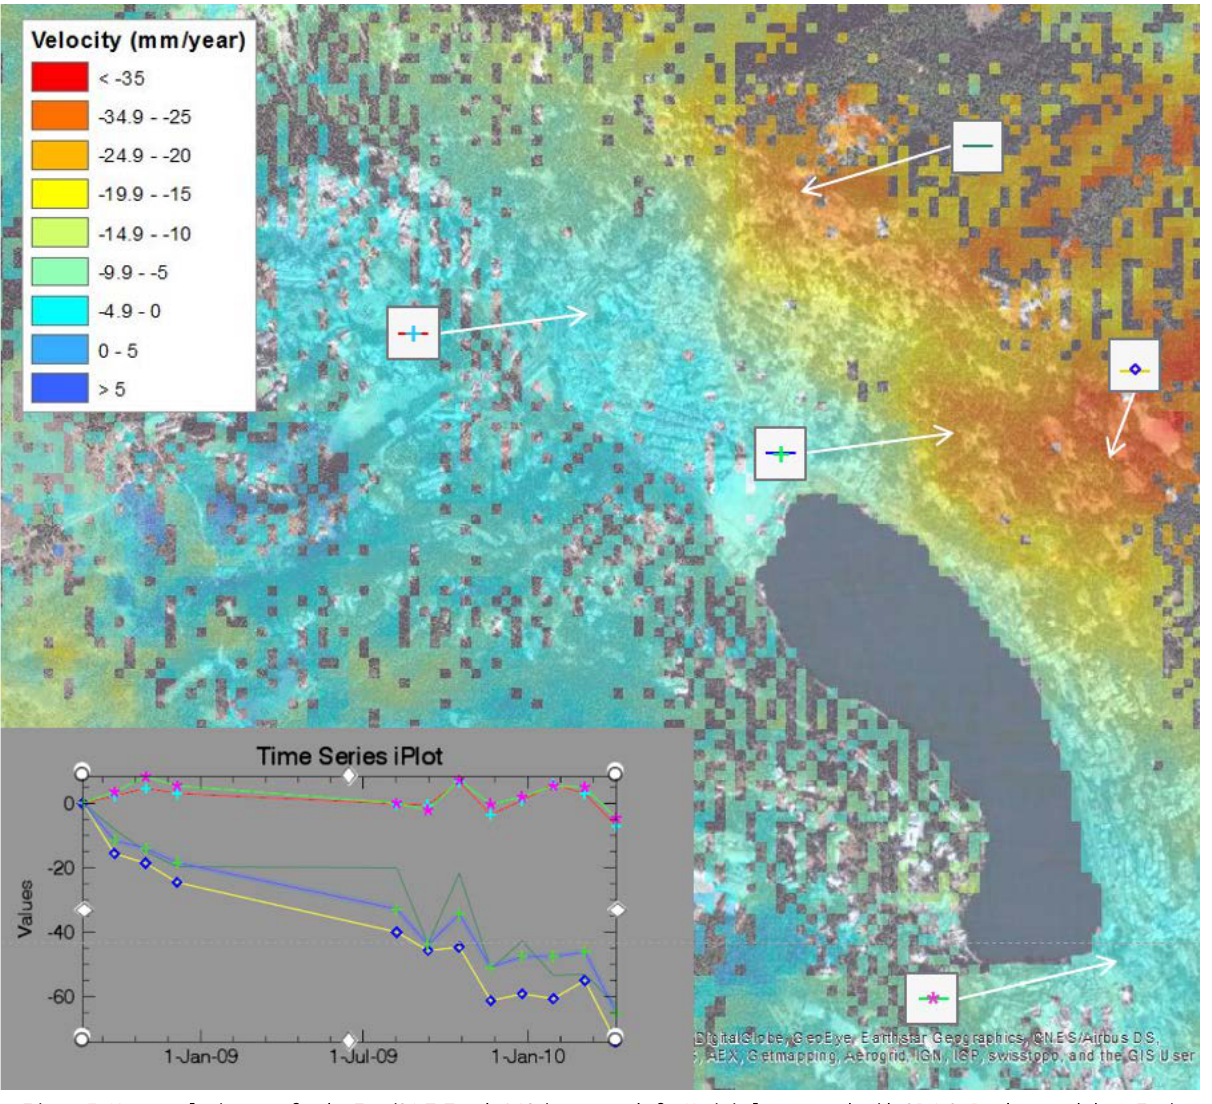
Figure 7: Mean velocity map for the EnviSAT Track 248 image stack for Nainital processed with SBAS. Background data: Esri, DigitalGlobe, GeoEye, i-cubed, USDA, USGS, AEX, Getmapping, Aerogrid, IGN, IGP, swisstopo and the GIS User Community. Insert: Time series from August 2008 to August